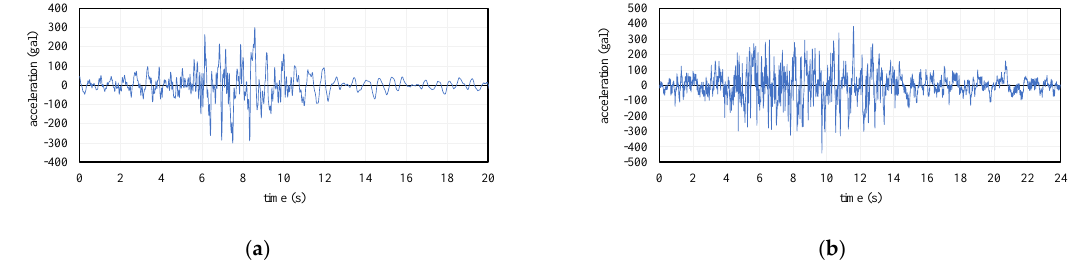
Figure 18. Input acceleration waveforms: ( a ) wave A; ( b ) wave B.